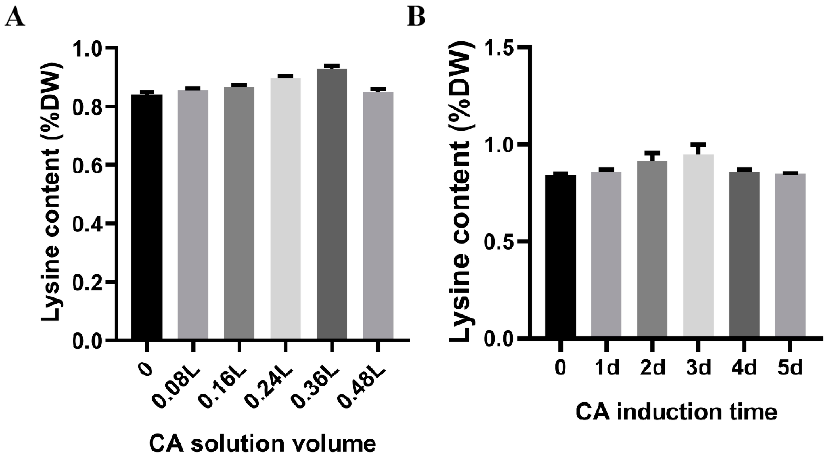
Figure 4. Effects of different citric acid inductions on the content of lysine in fruiting body of Flammulina filiformis . ( A ) Effect of different contents of citric acid on the content of lysine in fruiting body. ( B ) Effect of citric acid induction time on lysine content in fruiting body.